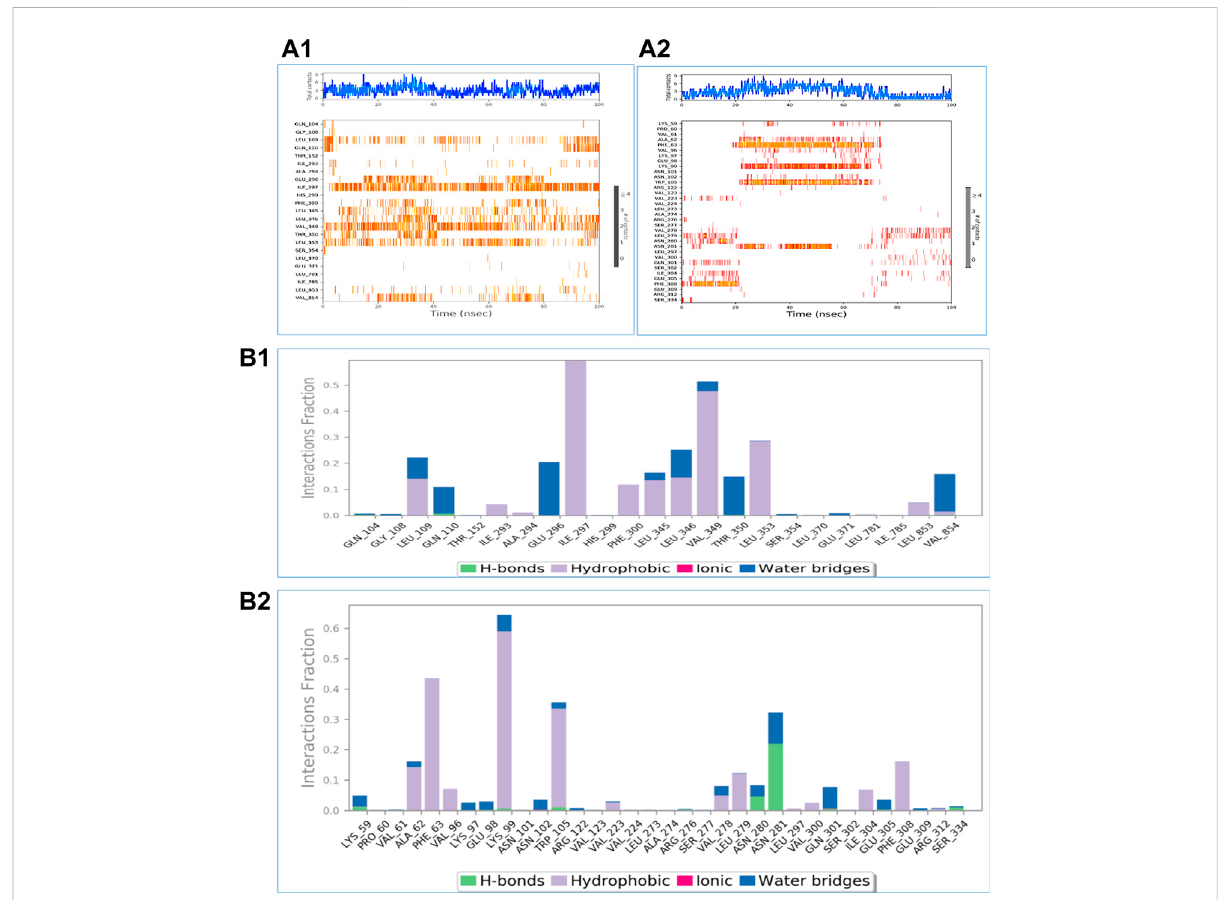
FIGURE 2 A time-based depiction of the multiple interactions and contacts including hydrogen, hydrophobic, ionic bonds, and water bridges between bergapten vs. 4UX2 and 1T3S are presented in (A1,A2) , respectively. The total number of speci fi c interactions between the protein and the ligand is shown in the top panel. The interacting residues with the ligand are shown in the bottom panel. Some residuesform more than one speci fi ccontact with the ligand, and these are indicated by deeper hue of Orange, according to the scale to the right of the plot. (B1,B2) exhibit protein interactions between 4UX2 and bergapten and 1T3S and bergapten, respectively. These interactions are categorized as hydrogen bonds, hydrophobic, ionic, and water